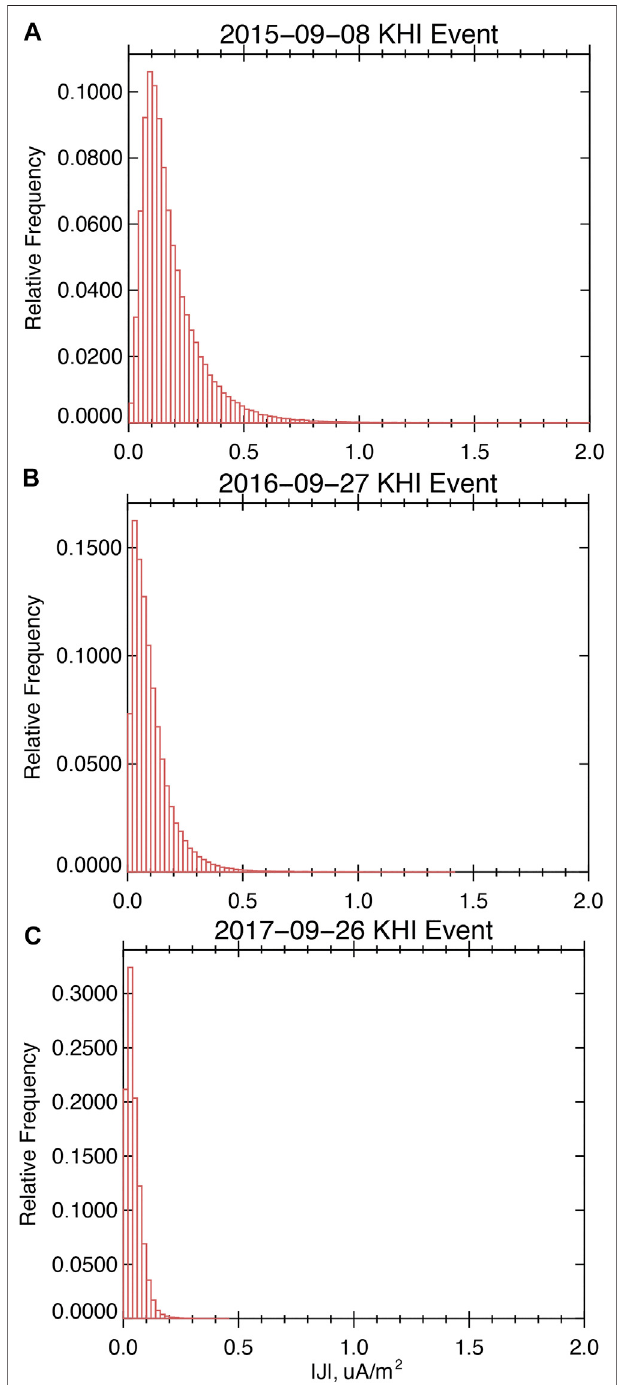
FIGURE 10 | Histograms of electric current density, measured using data from the Fast Plasma Investigation (FPI) for the three KHI intervals on (A) 2015-09-08, (B) 2016-09-27, and (C) 2017-09-26.